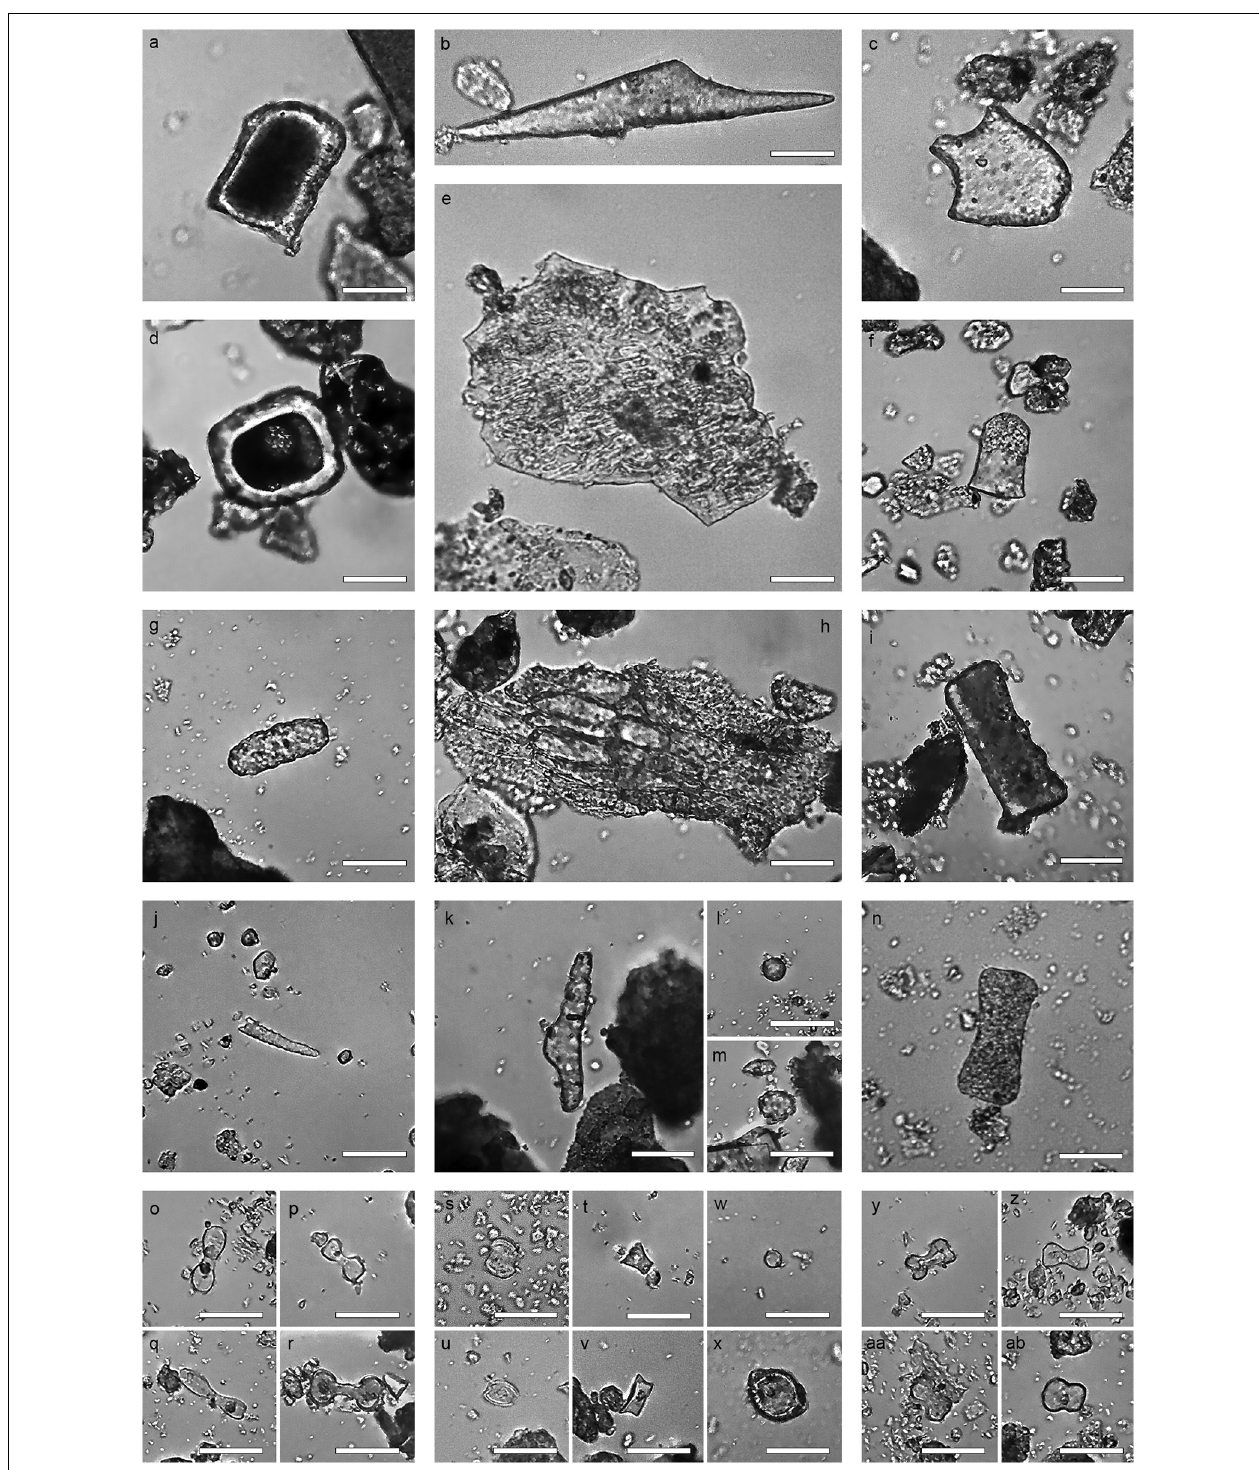
FIGURE 5 | Selected phytoliths from Mumba, morphotype and sample provenance: (a) Blocky, G2, (b) Scutiform, G2, (c) Bulliform, G2, (d) Blocky, G2, (e) Composite epidermal possibly Poaceae inflorescence, E4, (f) Polygonal prism Commelinaceae, E1, (g) Cylindroid granulate, F1, (h) Epidermal composite likely Cyperaceae, H1, (i) Tabular sinuate, C2, (j) Oblong granulate, E1, (k) Sclereid, C1, (l,m) Globular granulate, B2, (n) Tabular scrobiculate, E2, (o) Large bilobate convex ends, H2, (p) Large bilobate flat ends, C2, (q) Large bilobate notched ends, B2, (r) Large bilobate concave ends, C2, (s) Short saddle, H2, (t) Tower, C1, (u) Squat saddle, E2, (v) Rondel, C1, (w) globular psilate, E4, (x) globular hemisphere, G1, (y) Small bilobate notched ends, C1, (z) Small bilobate flat ends, C1, (aa) Small bilobate concave ends, C2, (ab) Small bilobate covex ends, E1.